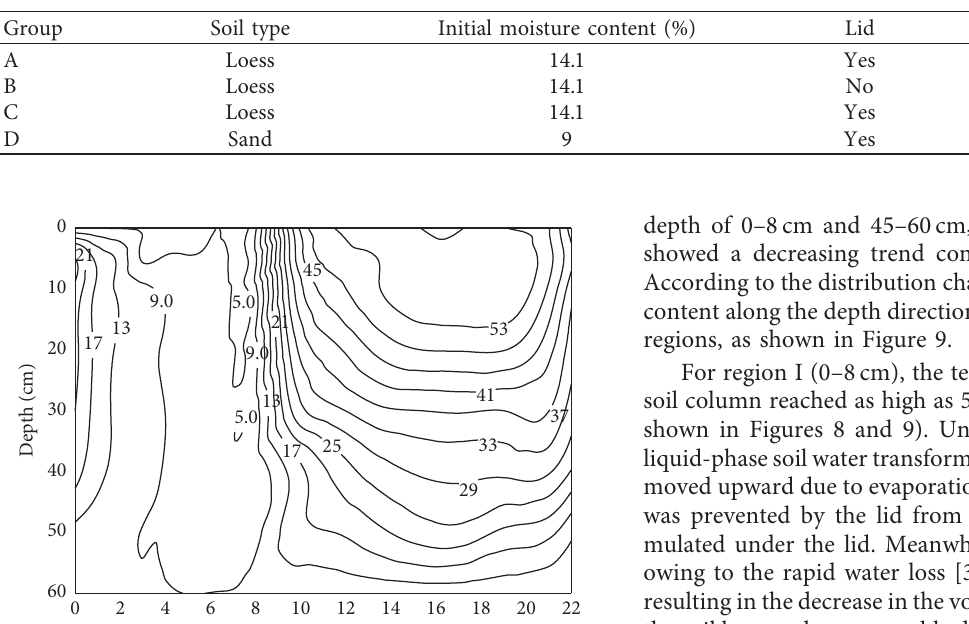
Table 3: Test design of the water vapor migration.